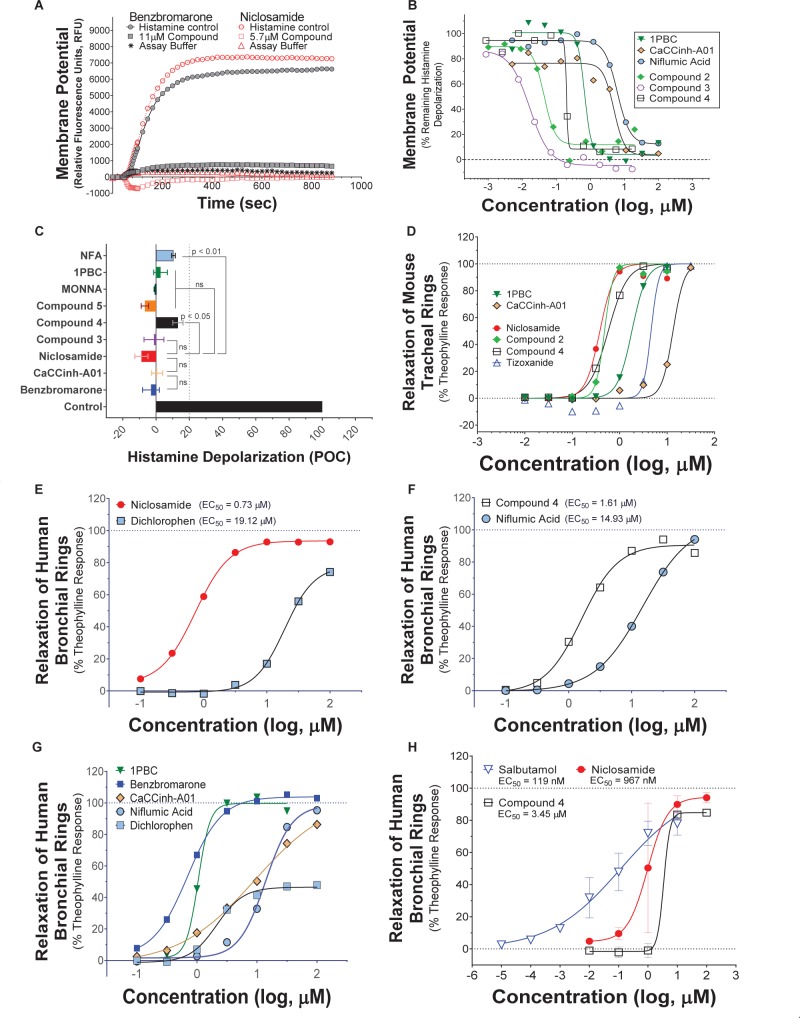
Niclosamide and related compounds block histamine depolarization of airway smooth muscle cells and provided robust bronchodilation of carbachol or histamine pre-contracted mouse and human airways. Representative kinetic traces of fluorescence recordings from the FLIPR membrane potential assay using primary human ASM cells (A). Histamine-induced a robust increase in fluorescence corresponding to depolarization which was fully blocked by the TMEM16A antagonists benzbromarone and niclosamide (A). Niclosamide and related compounds provided potent inhibition of the histamine-induced ASM depolarization (B), with the average maximum inhibition from dose-response studies exceeding 80% or <20 percent of control (POC) response to vehicle (Control); n = 2–15 (C). In wire myograph assays using carbachol pre-contracted mouse tracheal rings, niclosamide and related analogs, Cpd 2 and Cpd 4, provided sub-μM bronchodilation and improved potency over the two TMEM16A benchmark antagonists run in parallel (D). Niclosamide and Compound 4 also provided robust relaxation of human bronchial rings pre-contracted with carbachol, with results in panels (E,F) being wire myograph studies using rings from the same donor and involving simultaneous tests in parallel of the four compounds shown. Using a separate donor, effective bronchodilation of carbachol pre-contracted human airway rings was also observed with five benchmark TMEM16A antagonists of distinct chemotypes (G). Niclosamide and Compound 4, additionally provided robust relaxation of histamine pre-contracted human bronchial rings (n of 2–3) as shown in the wire myograph results in panel (H) on airway rings from different donors. The results from separate myograph studies on the β-agonist salbutamol are overlaid for comparison (n of 3 donors). As a precaution, all wire myograph studies using human bronchial rings included 5 μM indomethacin in the bath solution to eliminate any possible indirect effects due to prostaglandins. Mean ± SEM. Significant differences from benzbromarone or niclosamide (C) was determined with unpaired t-test (ns, not significant).